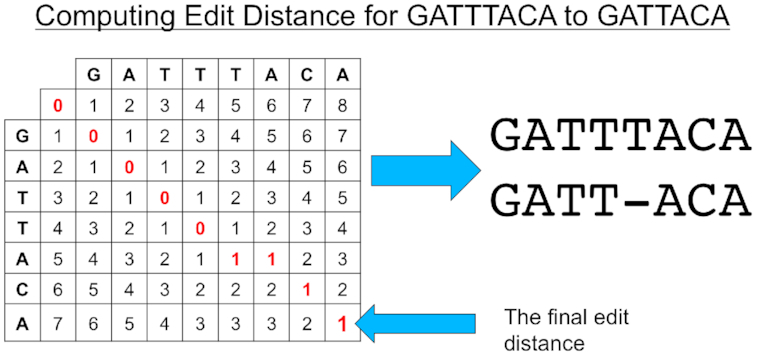
A diagram showing how edit distance is computed for 2 strings. Each cell of the matrix represents the minimum of 3 possible values: (1) the left cell plus 1 (representing the cost of adding a gap on the left string); (2) the upper cell plus 1 (representing the cost of adding a gap on the top string; and (3) the upper left cell plus 0, if the top string equals the left string, or 1, if the characters do not match to account for the cost of another substitution.